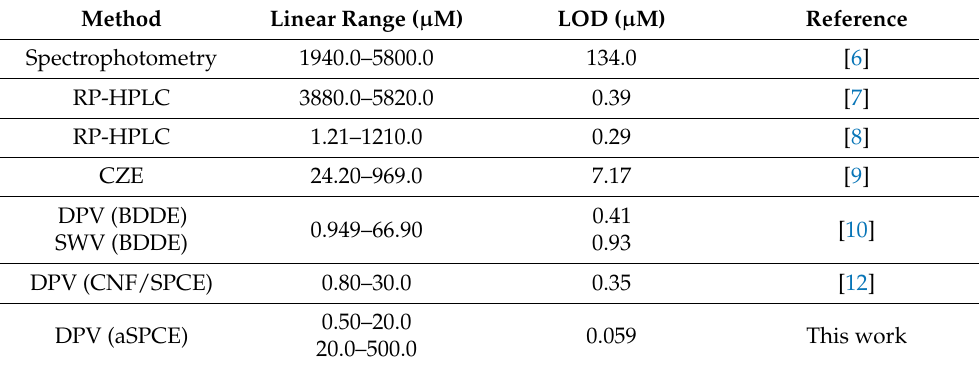
Table 1. Comparison of different methods for IBP determination in pharmaceutical